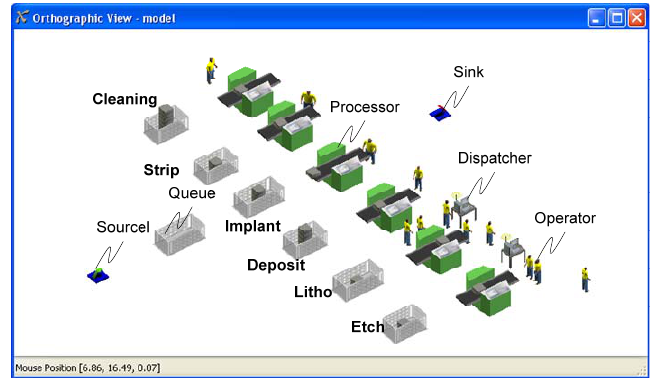
Figure 8. “A snapshot of Flexsim model from